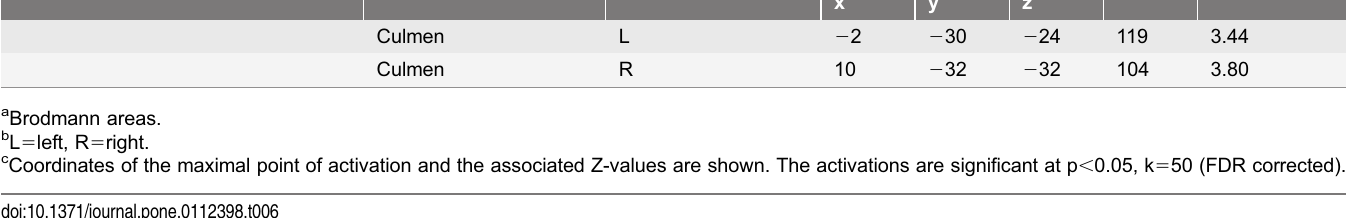
Subjects evaluated emotional faces during the fMRI session. We found activation differences between repressors and sensitizers that confirm in part our hypothesis. Repression was associated with increased cortical activation in frontal, parietal, temporal, and occipital areas and the cerebellum during encoding of directly threatening faces (i.e. angry facial expression) but not as hypothesized during encoding of indirectly threatening faces (i.e. fearful facial expression). As expected, the happy versus neutral contrast did not show any significant activation differences between repressors and sensitizers. Sensitizers did not exhibit heightened neural activation in any of the contrasts compared to